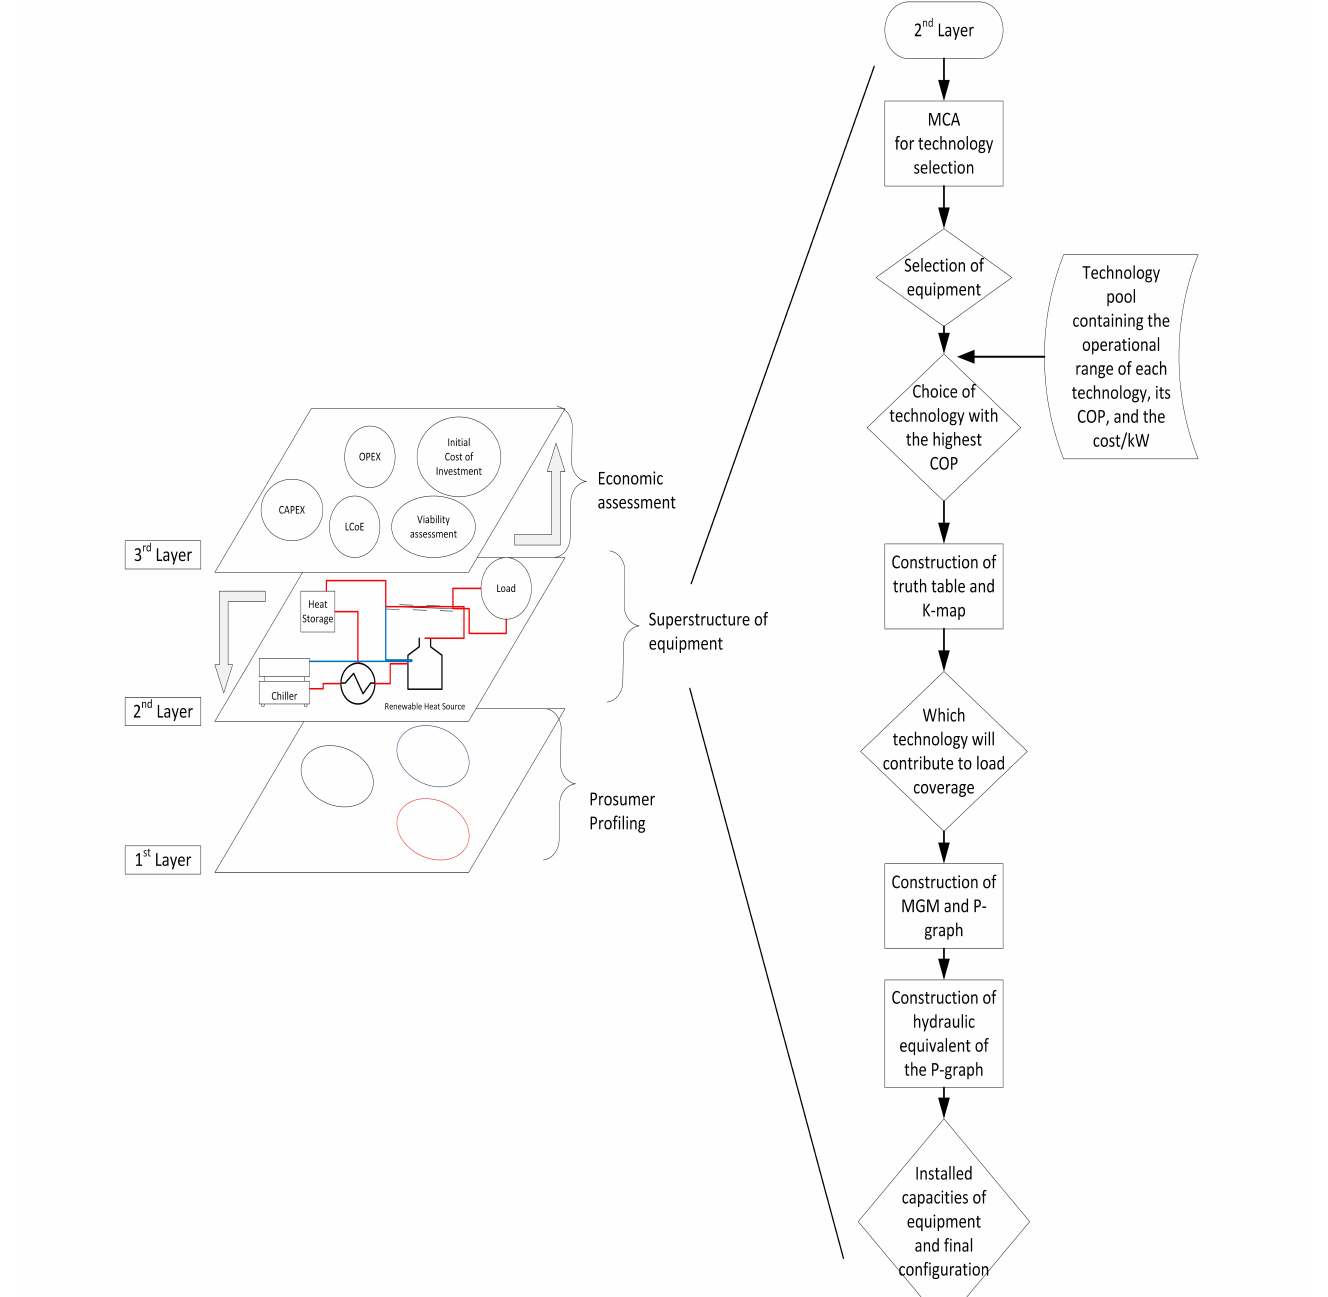
Figure 1. Flowchart representing the research procedure of the 2nd layer of